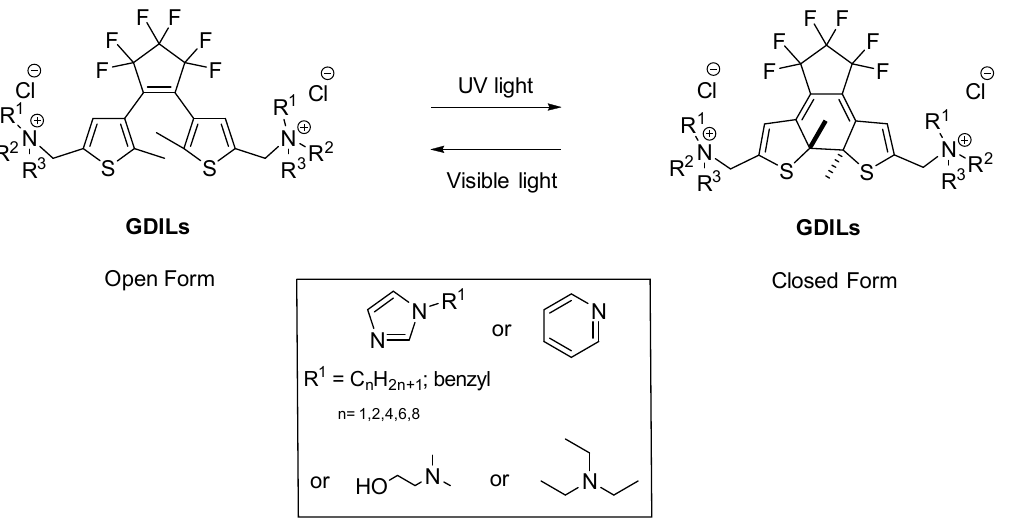
Scheme 4. General structures of gemini diarylethene based ionic liquids (GDILs) in the open and closed forms.